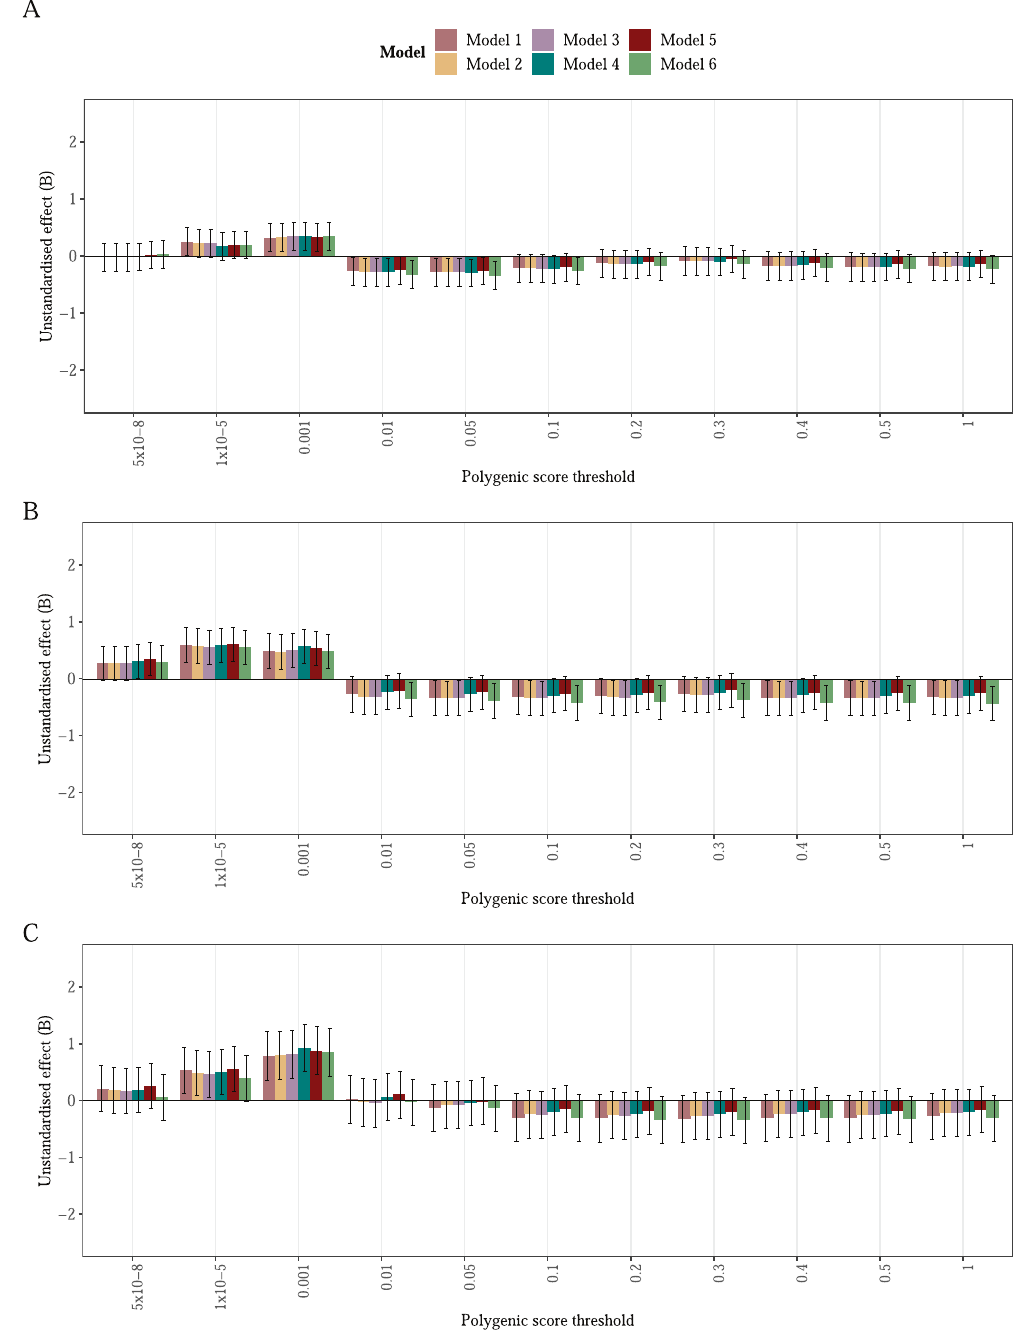
Fig. 1 Anorexia nervosa polygenic score (PGS) associated with disorder severity measured as Clinical Impairment Assessment (CIA) total score. Bars represent beta estimates ± standard errors. A is based on 2843 individuals with anorexia nervosa and additional eating disorder diagnoses during their lifetime. B is based on 1839 individuals with any clinically ascertained anorexia nervosa diagnosis. C is based on 976 individuals with a clinically ascertained anorexia nervosa restricting subtype. The estimates in model 4 are adjusted for covariates included in the main model: Principal components 1 – 10, treatment region, age, sex, follow-up time and eating disorder diagnosis when including individuals with any eating disorder diagnosis ( n =